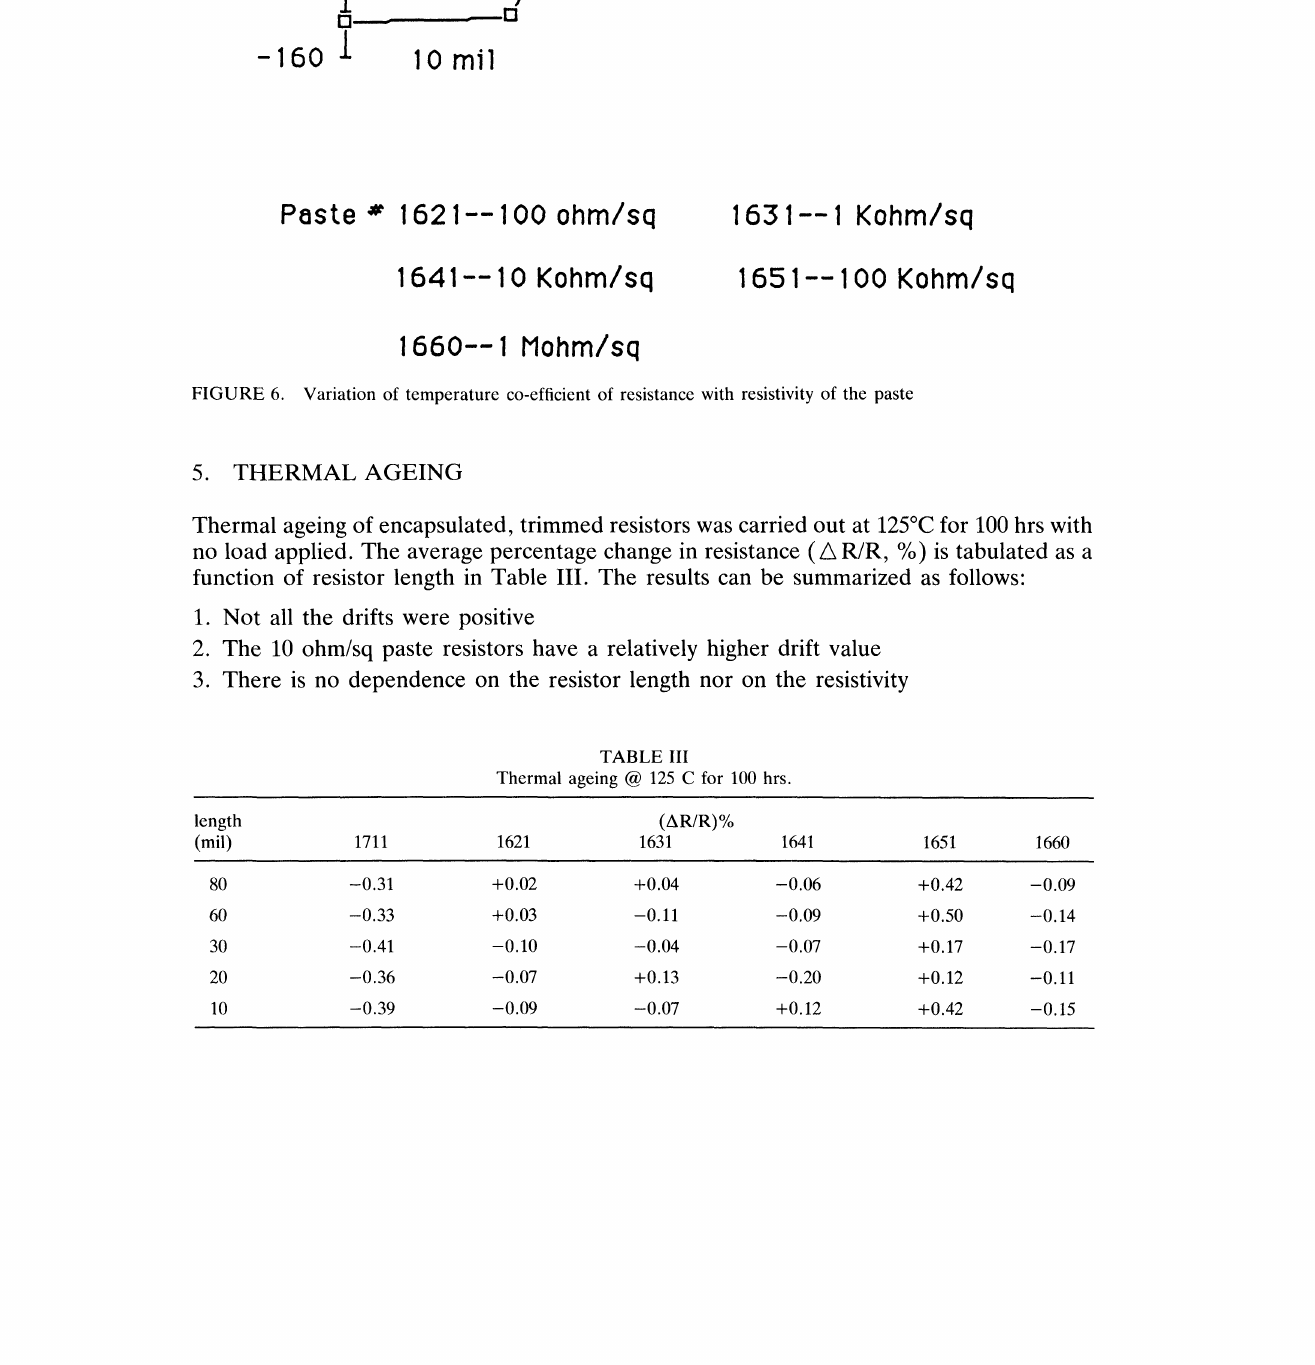
FIGURE 6. Variation of temperature co-efficient of resistance with resistivity of the paste